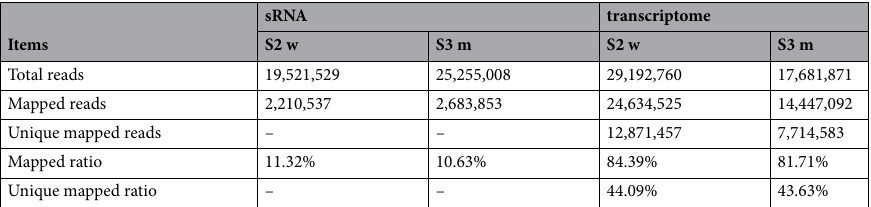
Table 2. Statistics of the clean reads mapped to the genome. Total reads: The total number of clean reads obtained by sequencing the sample. Mapped reads and Mapped ratio: The number and the ratio of the clean reads mapped to the reference genome. Unique mapped reads and Unique mapped ratio: The number and the ratio of the unique reads mapped to the reference genome. − no statistics.